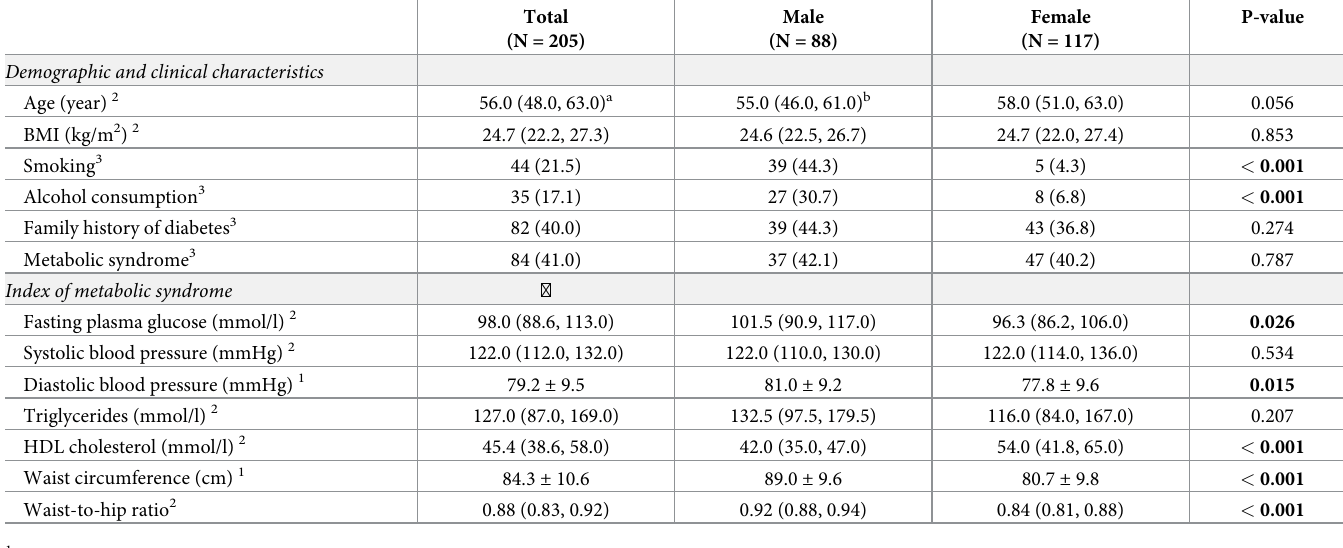
Table 1. Comparison of baseline characteristics (age, BMI, smoking, and alcohol consumption) and index of MS (fasting blood glucose, blood pressure, TG, HDL-C, waist circumference) between males and females.